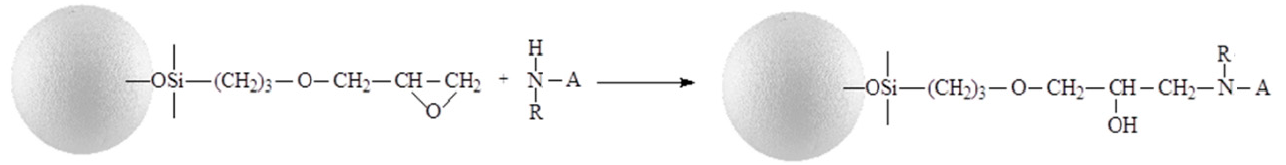
Figure 2. Immobilization of chiral selector (A) onto silica gel via the epoxy-group.